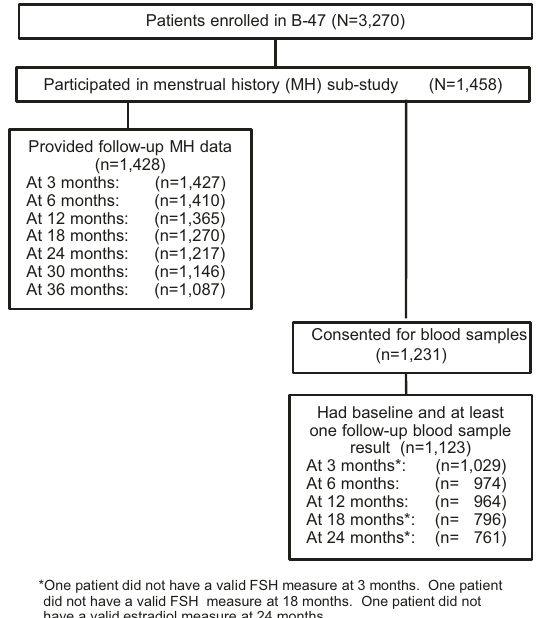
Fig. 1 CONSORT Diagram. NSABP B-47 Menstrual History